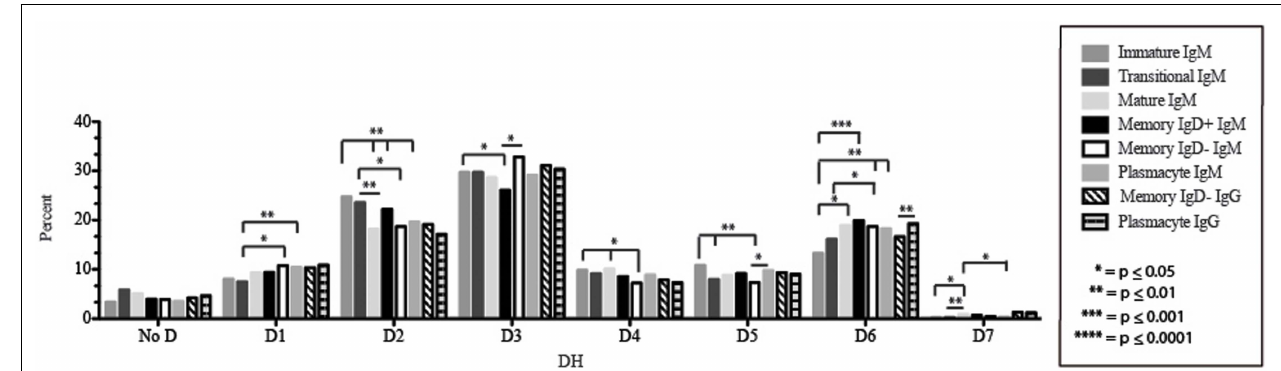
memory IgD + , memory IgD − B cells, and plasmacytes are displayed. All comparisons were made using χ 2 -test or Fisher’s exact test as appropriate. Significant differences among each fraction in the different mice are indicated by asterisks: * p ≤ 0.05, ** p ≤ 0.01, *** p ≤ 0.001, **** p ≤